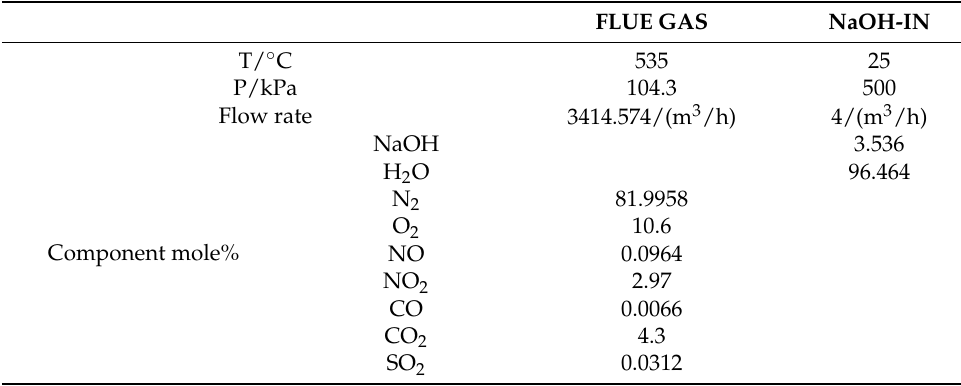
Table 6. Parameters of flue gas and NaOH solution entering the spray tower.